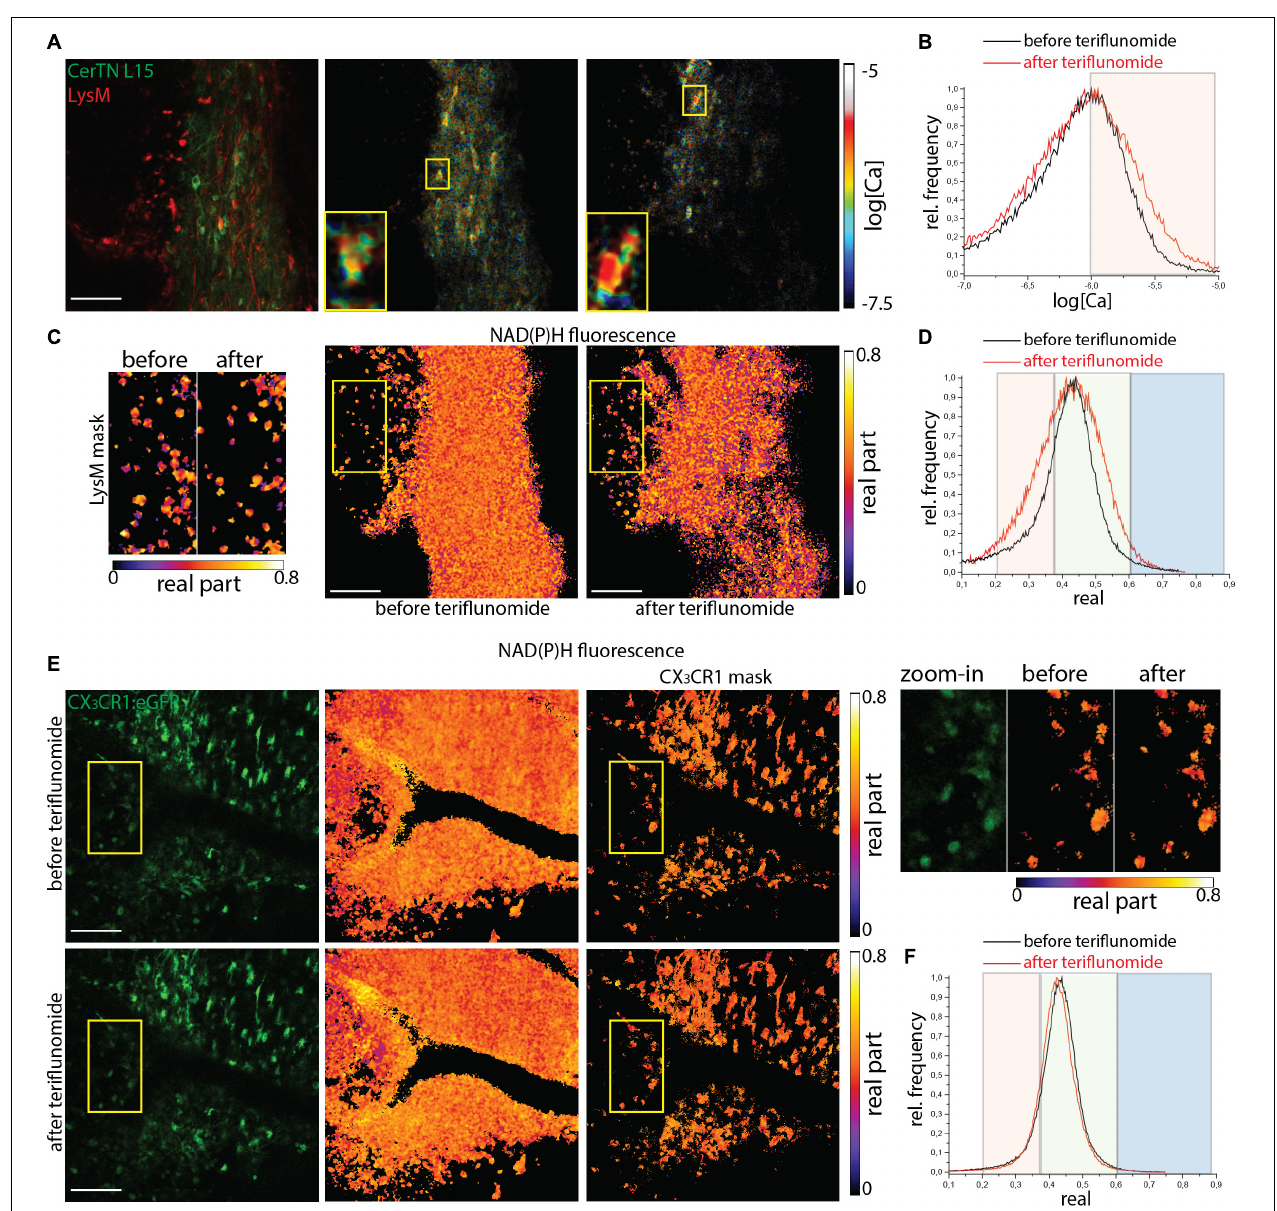
FIGURE 4 | NOX enzymes activation by NAD(P)H-FLIM and neuronal dysfunction by FRET-FLIM of TN L15 in the brain stem of mice affected by EAE under treatment with teriflunomide. (A) Fluorescence intensity image and corresponding log[Ca] images of the same region in the brain stem of a CerTN L15 x LysM tdRFP mouse affected by EAE (score 2.5), before and after teriflunomide treatment: tdRFP fluorescence in LysM + cells (red) and Cerulean and Citrine fluorescence in Thy 1 cells (green). Insets depict single untreated and treated neurons, respectively, displayed enlarged. (B) Histograms of neuronal Calcium in log[Ca] with and without teriflunomide treatment. (C) NAD(P)H fluorescence real part images of the same untreated and treated region in the brain stem of the CerTN L15 x LysM tdRFP mouse as in (A) . Enlarged images of the real part of the NAD(P)H fluorescence phasor vector in LysM + cells, before and after treatment. (D) Histograms of the real part of the NAD(P)H phasor vector depicting the NOX enzymes activation regimes in the overview images in (C) . (E) eGFP fluorescence intensity images and NAD(P)H fluorescence real part images of the same untreated and treated region in the brain stem of a CX 3 CR1:eGFP mouse affected by EAE (score 3.0), at a lesion site. Upper raw display the NAD(P)H in all cells, the lower raw the NAD(P)H in CX 3 CR1 + cells. Yellow frames depict the regions of phagocyte-shaped CX 3 CR1 + cells displayed enlarged (right side). (F) Histograms of the real part of the NAD(P)H phasor vector depicting the NOX enzymes activation regimes in the overview images in (E) . Scale bars represent 100 µ